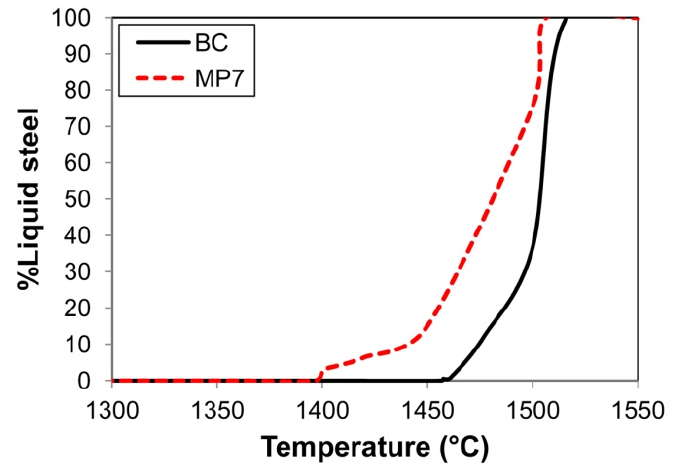
Figure 3. Solidification curves for BC and MP7 weld metal compositions as calculated in FactSage 7.3 [31].